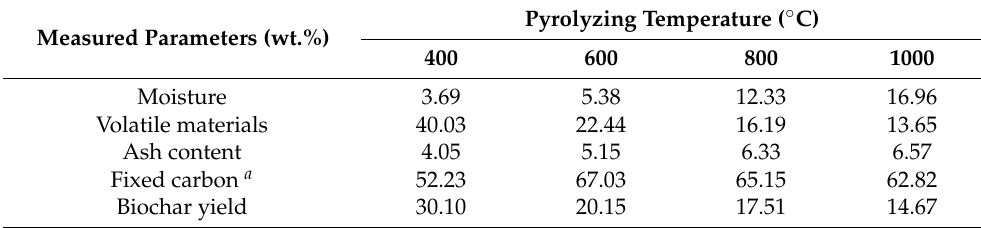
Table 2. Proximate analysis of biochar at different pyrolyzing temperatures. Measured Parameters (wt.%)